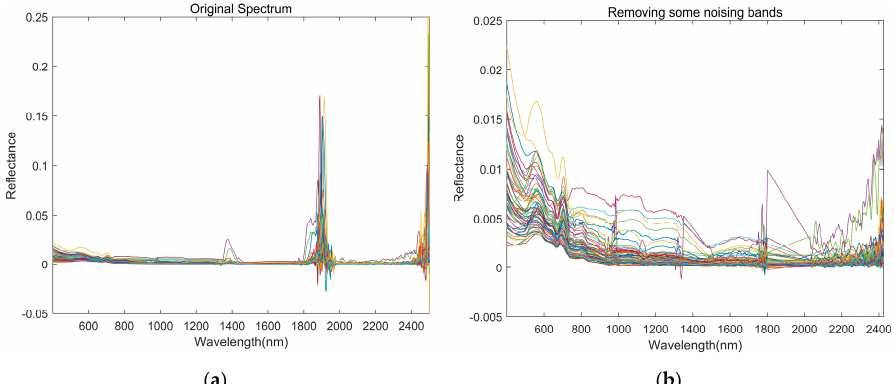
Figure 9. ( a ) Original spectra and ( b ) Denoised spectra used as inputs to the capsule network model in this study.